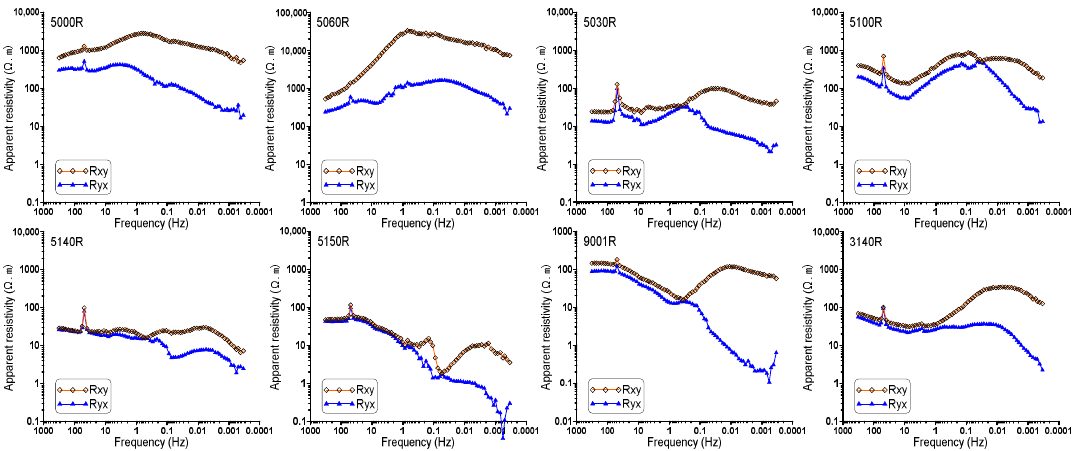
Figure 3. Typical apparent resistivity curves of the study area. Detailed captions are in the text.